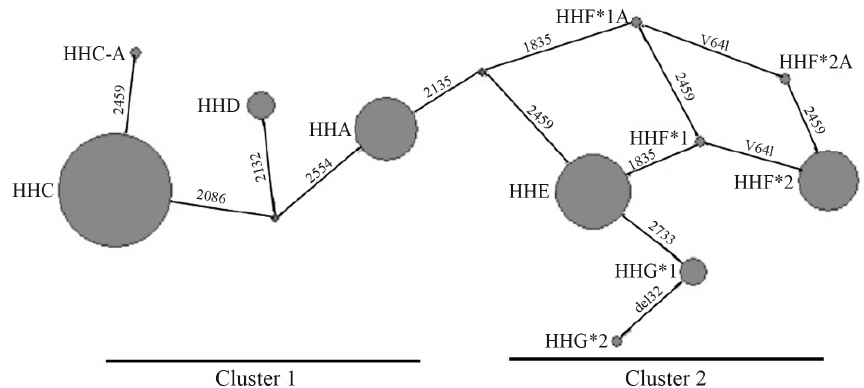
Figure 2 - Median-joining network of the CCR2-CCR5 haplotypes. The newly identified haplotypes are defined as HHC-A, HHF*1A and HHF*2A. The network was generated using Network 4.8 (Fluxus Engineering). The size of each node is proportional to the haplotype frequency. The numbers beside each line indicate the position of the nucleotide mutation.